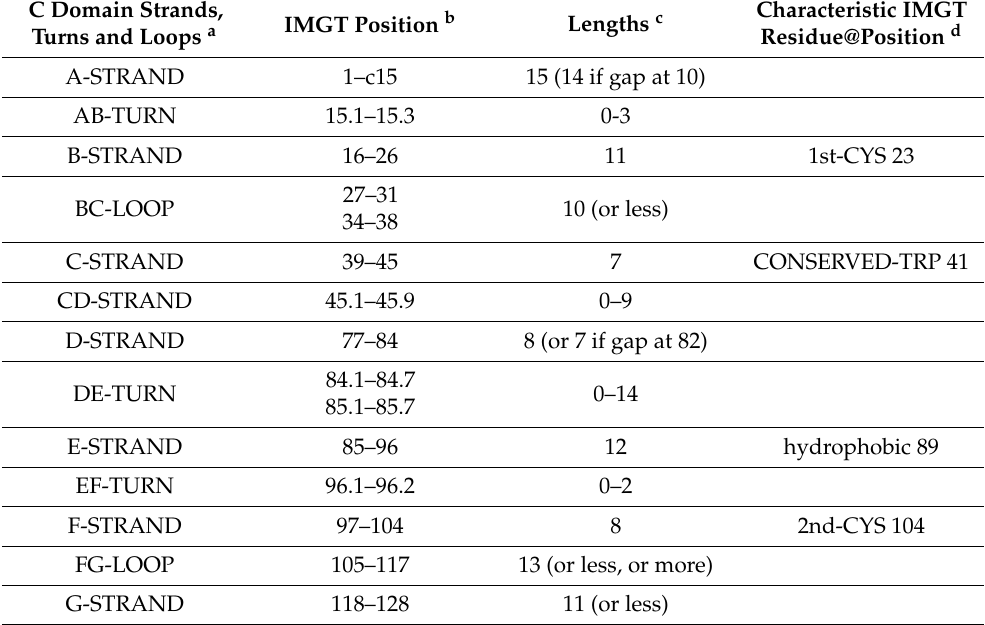
Table 4. C-domain strands, turns and loops, IMGT positions and lengths, based on the IMGT unique numbering for C-domain (C-DOMAIN and C-LIKE-DOMAIN) [68]. (With permission from M-P. Lefranc and G. Lefranc, LIGM, Founders of IMGT ® , the international ImMunoGeneTics information system ® ,